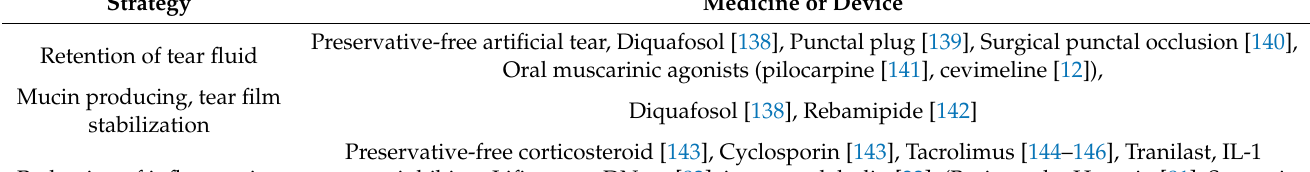
Table 1. Possible treatments/prophylaxis of ocular cGVHD at present and in the future [3,6,12,132–134,136,137]. Strategy Medicine or